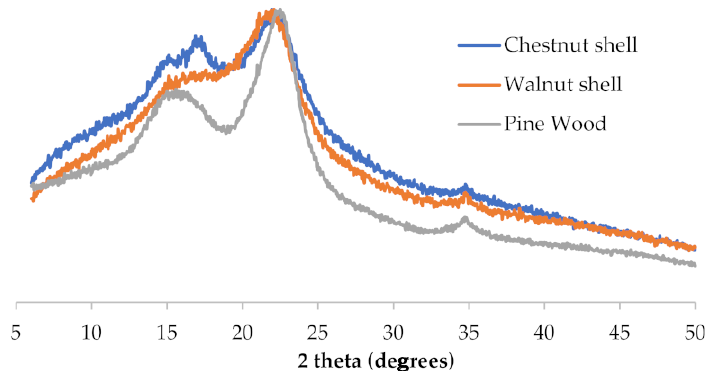
Figure 1. Powder X-ray diffraction of the different